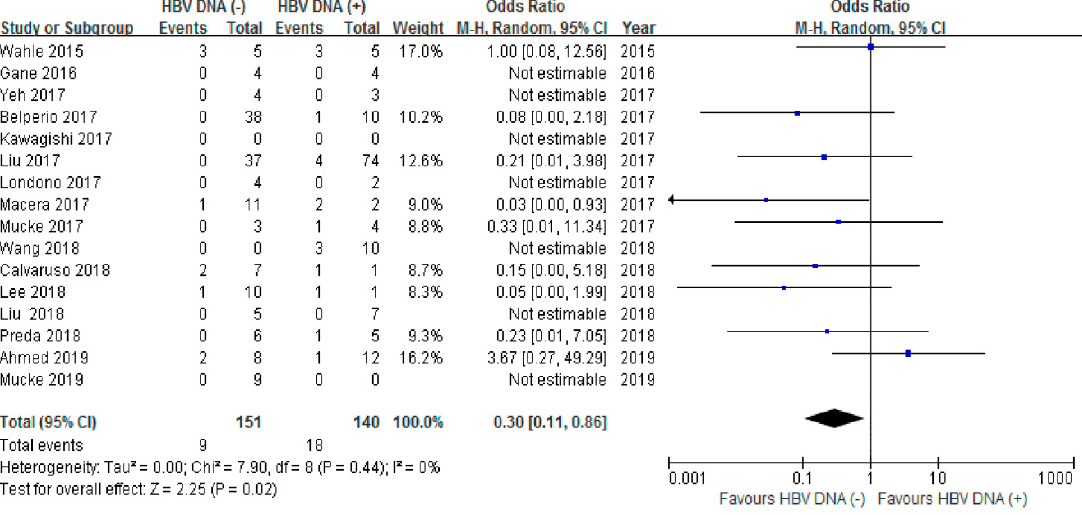
Figure 3. The risk of HBV reactivation according to baseline HBV DNA.